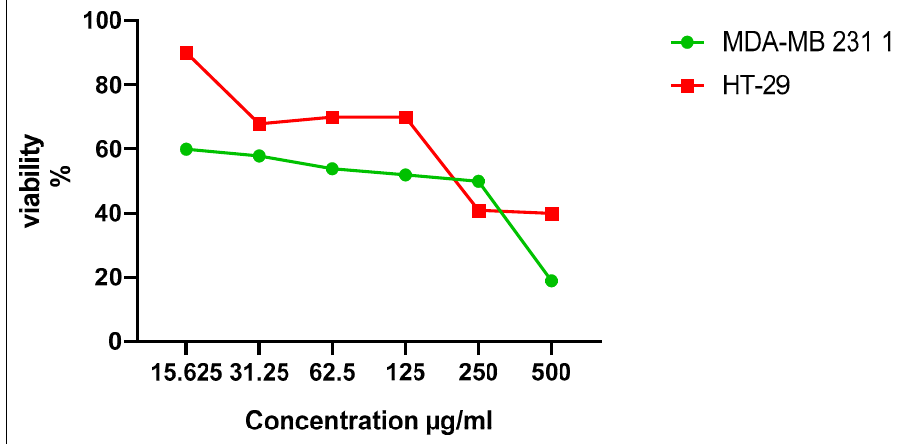
Figure 1. Curve of dose-response of cell viability assay after 72 h of treatment with hexane extract. MDA-MB-231 cell lines were found to be more vulnerable to C. colocynthis seed